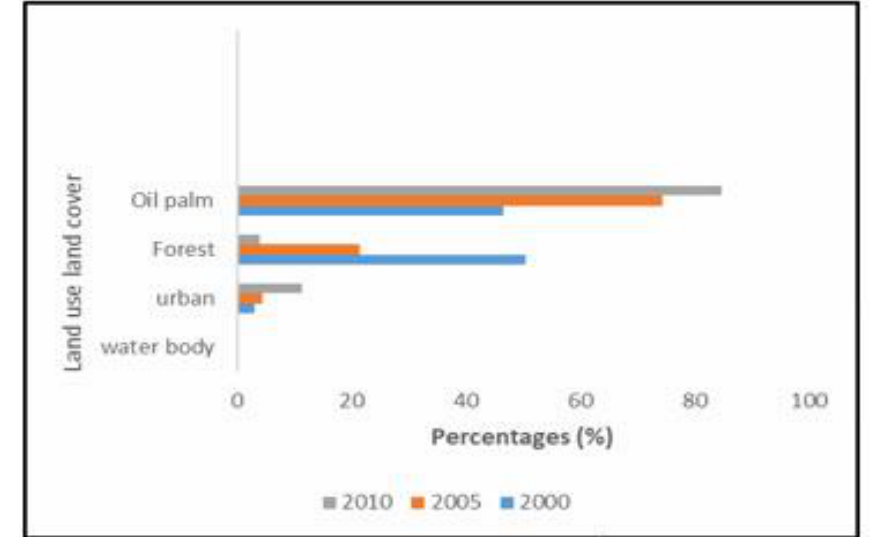
Figure 4. Percentages LULC classes of 2000, 2005 and